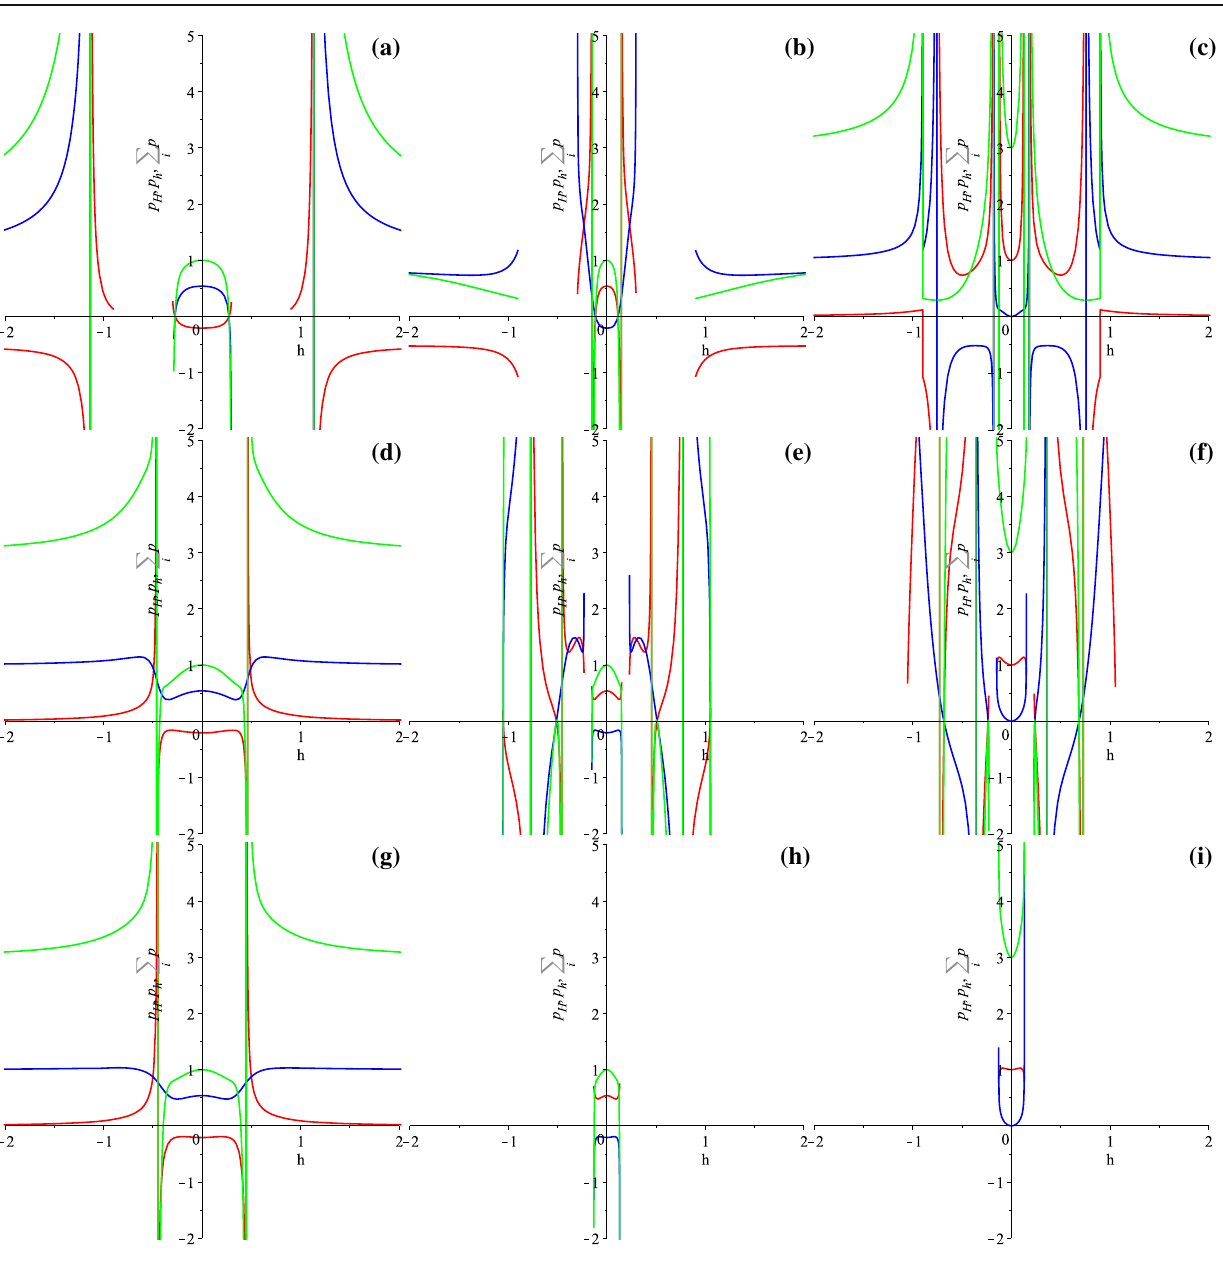
panel and H 3 branch on f panel; α > 0, β > 0, μ > 0 . 3 on g – i panels: H 1 branch on g panel, H 2 branch on h panel and H 3 branch on i panel (see the text for more